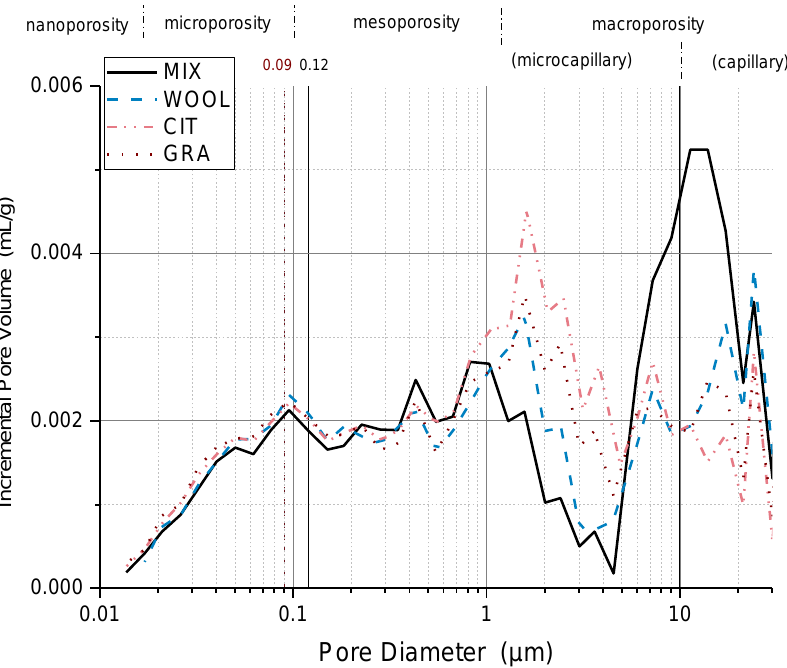
Figure 6. Incremental pore distribution from MIP analysis for the control samples (MIX) and the WOOL, CIT, and GRA specimens.